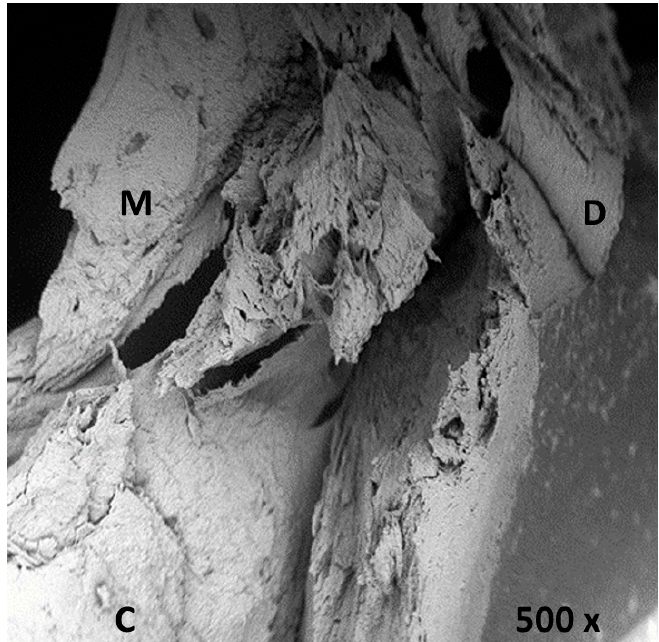
Figure 3. Stainless steel Lindemann type bur sample surface (D—debris, C—carbonization, M— microcracks and exfoliation).